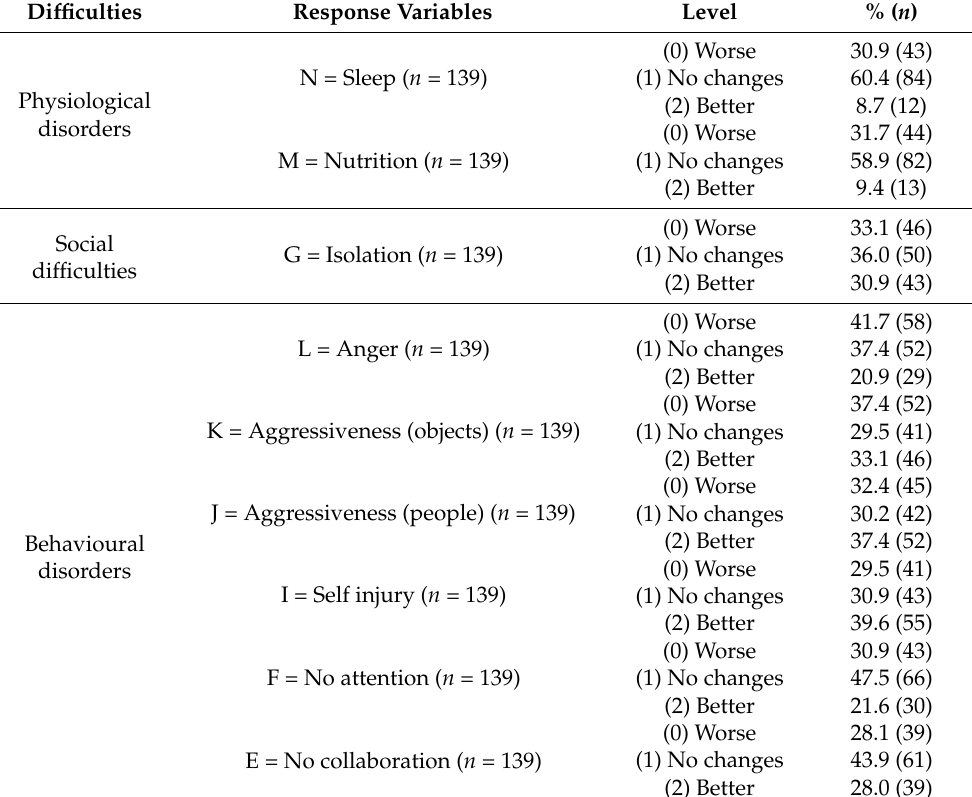
Table 1. Description of the response